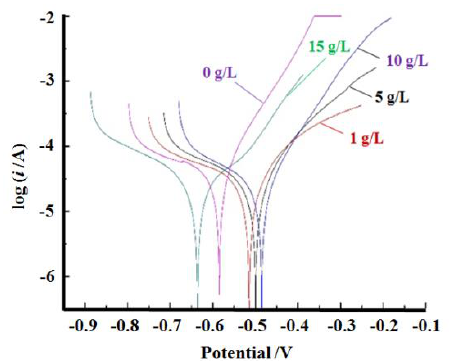
Figure 8. Tafel curves for composite coatings prepared at different diamond concentrations in the plating solution.